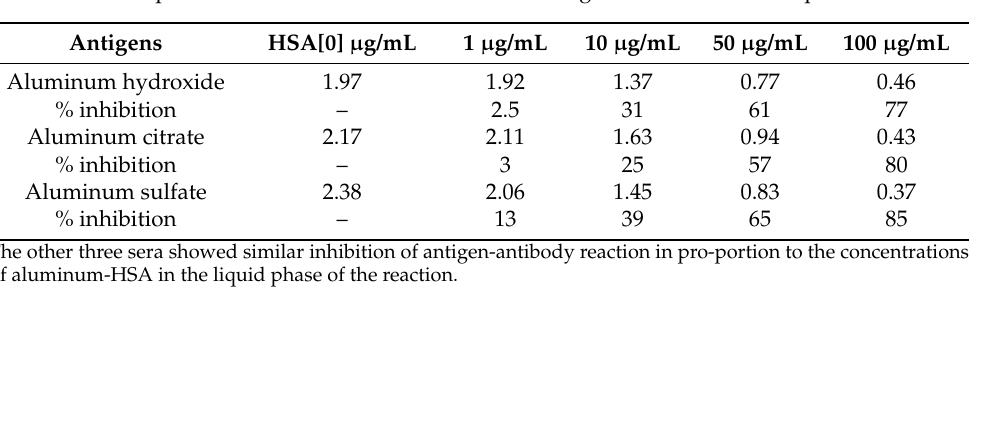
Figure 4. Percentages of samples with elevations in IgG antibodies against three different aluminum compounds in 94 healthy controls and 47 patients positive for antinuclear antibody (ANA) (mixed connective tissue disease [MCTD]). Dotted horizontal lines indicate the cutoff for positivity used in each assay, as calculated by receiver operating characteristic (ROC) analysis. The percentages of elevation, controls vs. patients, are indicated at the top of each distribution, while the thick short horizontal full bars indicate the respective means ( A ) The percentage of ANA-positive patients with elevated IgG antibodies against aluminum hydroxide was 16%, with an area under the curve (AUC) of 0.70; ( B ) The percentage of ANA-positive patients with elevated IgG antibodies against aluminum citrate was 16%, with an AUC of 0.72; ( C ) The percentage of ANA-positive patients with elevated IgG antibodies against aluminum potassium sulfate was 24%, with an AUC of 0.54. * While the p values for aluminum hydroxide and aluminum citrate may appear significant (both p < 0.0001), this is actually misleading, because the means for these two were actually lower than the means of their controls, which means that the resulting values were actually in reverse or insignificant. The p value for aluminum potassium sulfate was clearly not significant ( p = 0.3642). Table 3. Dose-dependent decrease in anti-aluminum binding to aluminum-coated